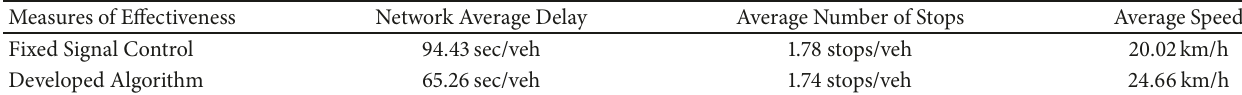
Table 3: Simulation result in 2X3 signalized